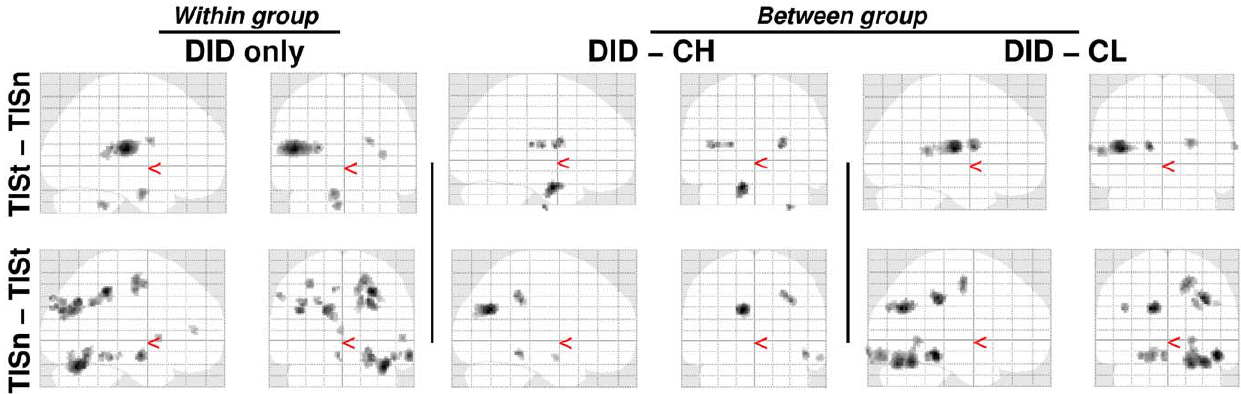
Figure 3. ‘‘Glass brain’’ renderings show differences in the processing of the trauma-related text (indicated with a small ‘t’) and the neutral text (indicated with a small ‘n’) within the trauma-related identity state (TIS). Differences in regional cerebral blood flow patterns for the dissociative identity disorder (DID) group (left) and the comparison of this group to the high (middle) and low (right) fantasy prone DID simulating controls (CH and CL respectively) are depicted. See Table 3 for the specific areas.